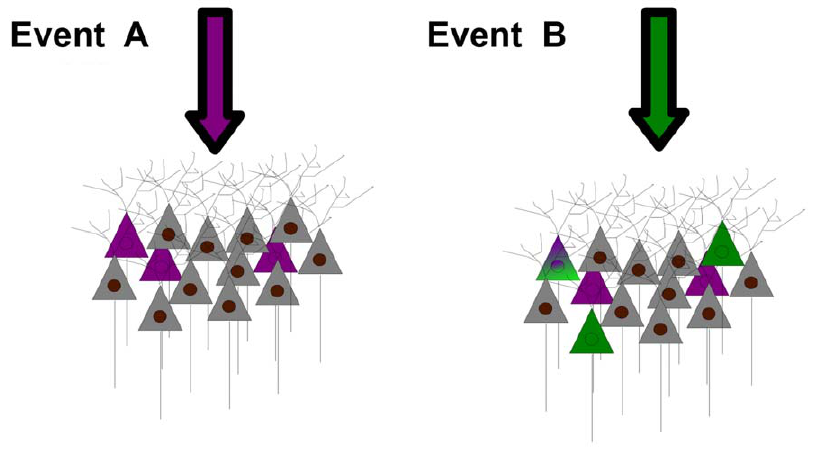
Figure 7. Independence of populations recruited to encode different events. When the hippocampus receives input specifying the occurrence of event A (magenta arrow), one subset of neurons is recruited to encode that event (magenta-tinted neurons). On the occurrence of event B (green arrow) another subset of neurons is recruited (green-tinted neurons). Because separate events are represented in an independent, partially overlapping manner, some neurons will be recruited to represent neither event, some neurons just one of the two events, and some neurons both events (note neuron with mixed color). A and B may be two events of the same modality in different contexts, such as the encoding of texture on two different platforms. Alternatively, A and B may be two events of different modality that occur in the same context, perhaps even occurring at the same time, such as the encoding of texture and reward location on the same platform.